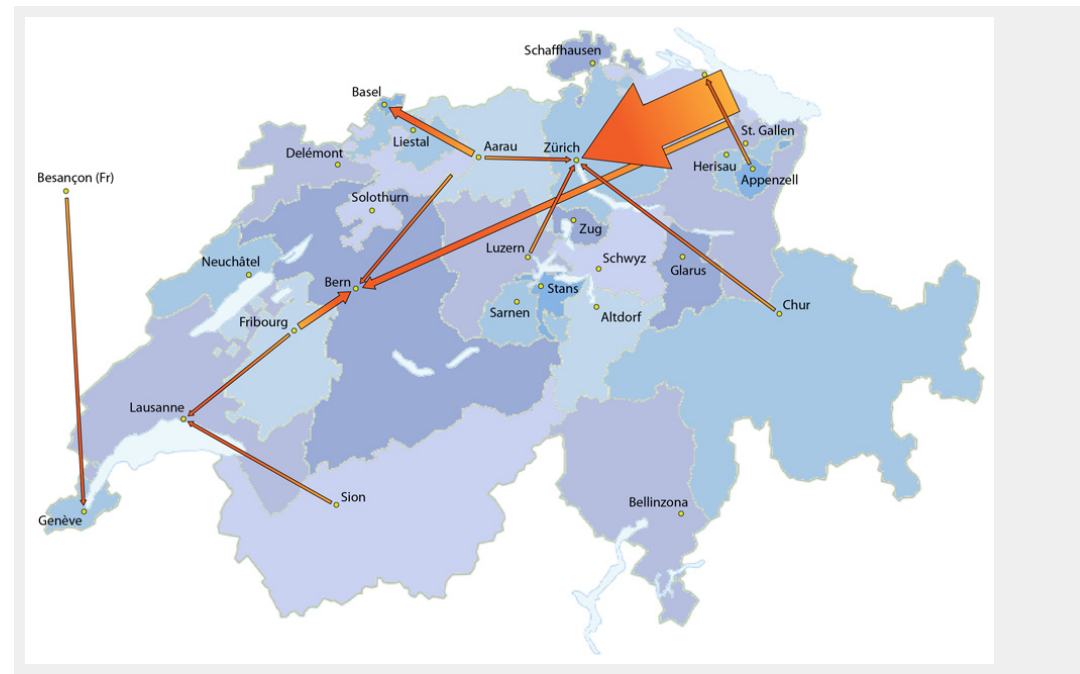
Figure 4 Geographical distribution of patient transfers in Switzerland. Transfers within France and Germany are not shown. Arrow size is proportional to the number of transfers. Thin arrows represent the transfer of 1 patient; arrows twice this width represent transfer of 2 patients; the large arrow from eastern Switzerland to Zurich represents the transfer of 21